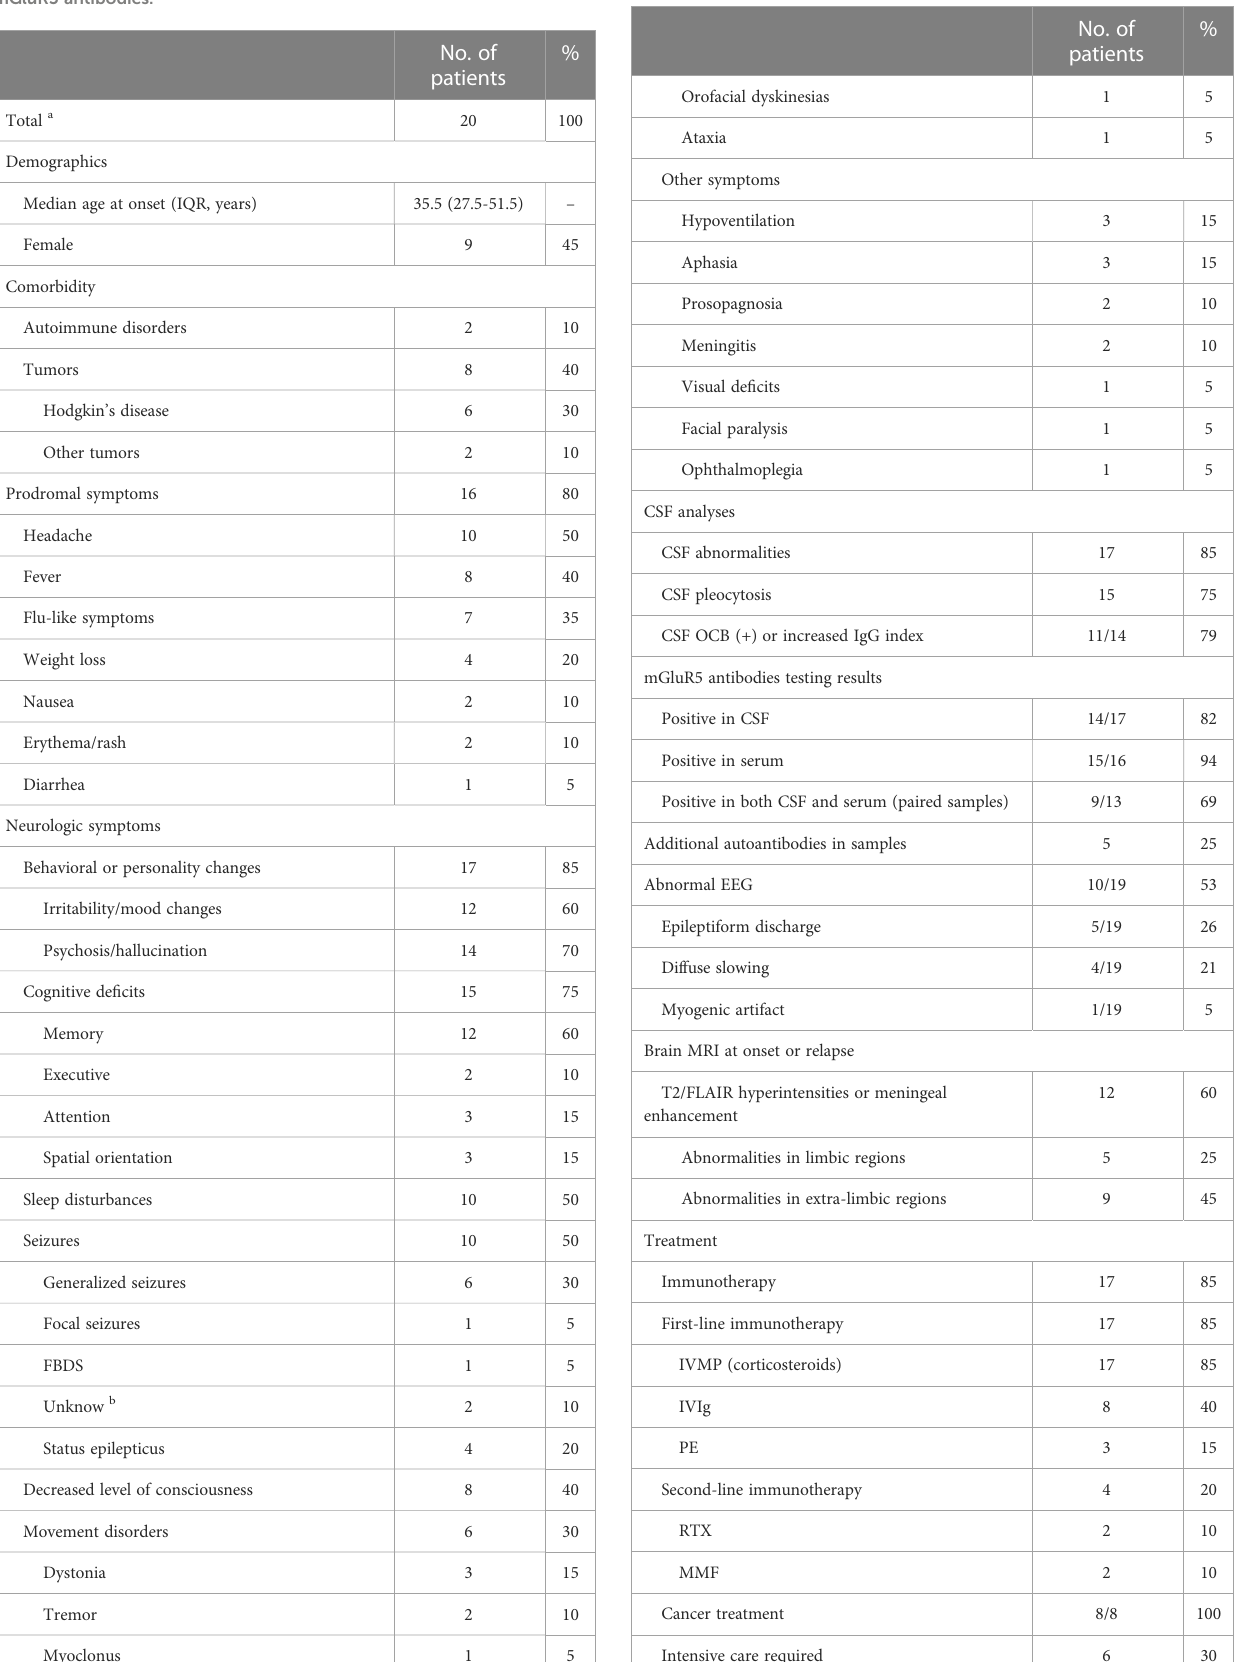
TABLE 2 Clinical features of 20 autoimmune encephalitis patients with mGluR5